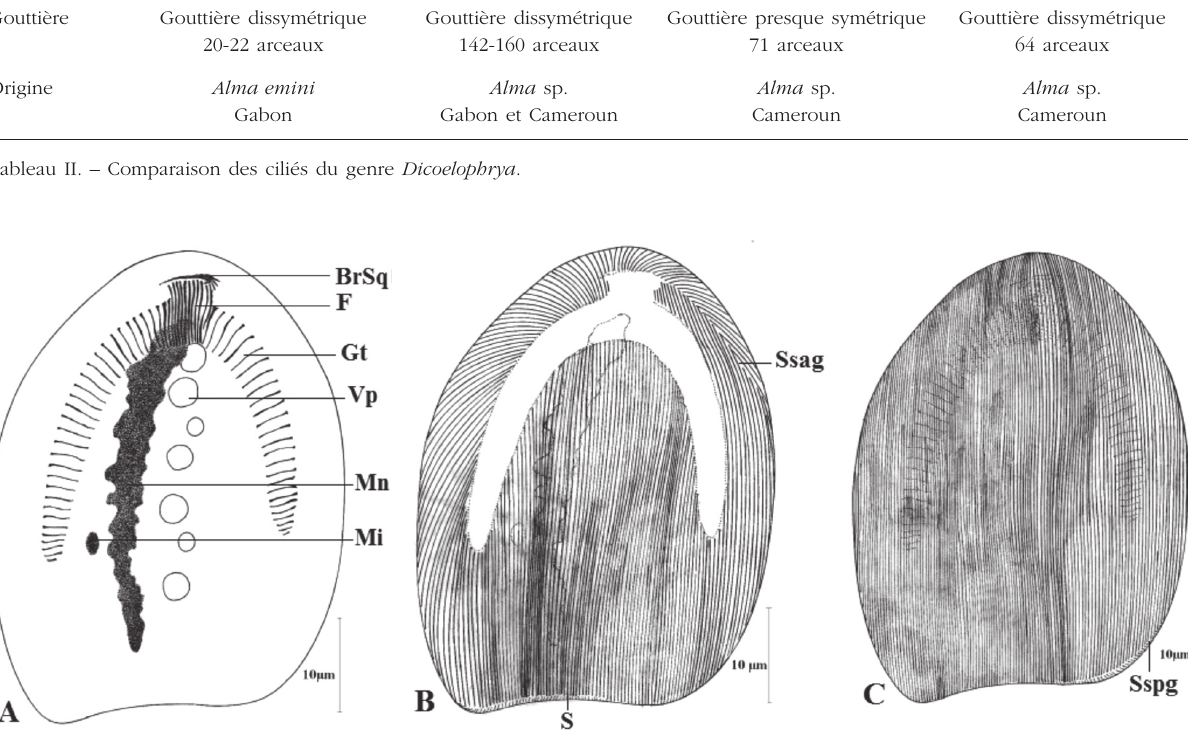
Figure 9. – Dicoelophrya mediovacuolata n. sp.